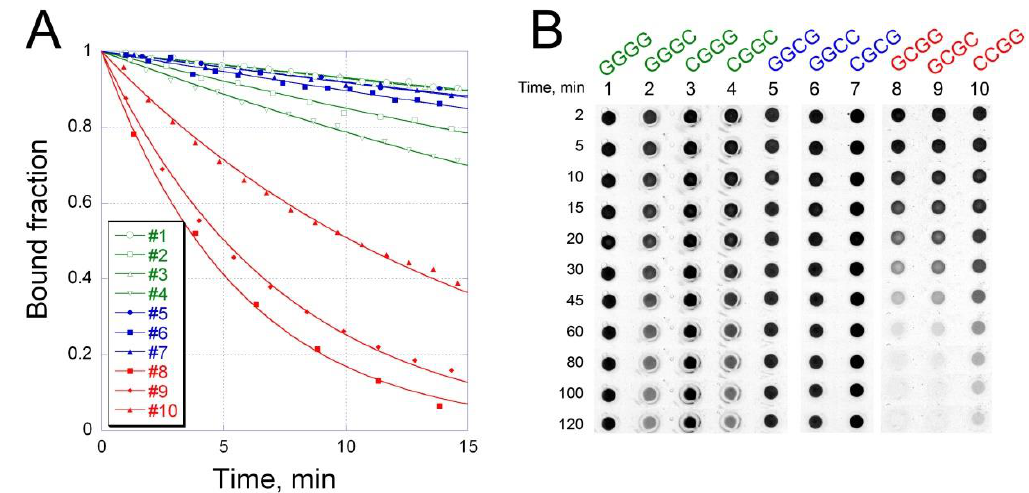
Figure 3. Kinetics of OA dissociation from DNA hairpins carrying 10 tetranucleotide binding sites in solution ( A ) and in 10% polyacrylamide gel (PAAG) ( B ). ( A ) Dissociation of OA–DNA complexes in buffer A was monitored by fluorescence at 550 nm after addition of 1% SDS. ( B ) Spontaneous dissociation of OA–DNA complexes. Complexes of OA with oligonucleotides 1–10 in buffer A were loaded into the wells formed in 10% PAAG. Images were taken under UV at indicated time intervals. Changes in OA fluorescence in the wells reflected time-dependent dissociation of complexes and drug diffusion into the gel. Dissociation curves and loading wells are colored according to the respective binding site: SGGS sites are in green; SGCS in blue; SCGS in red.